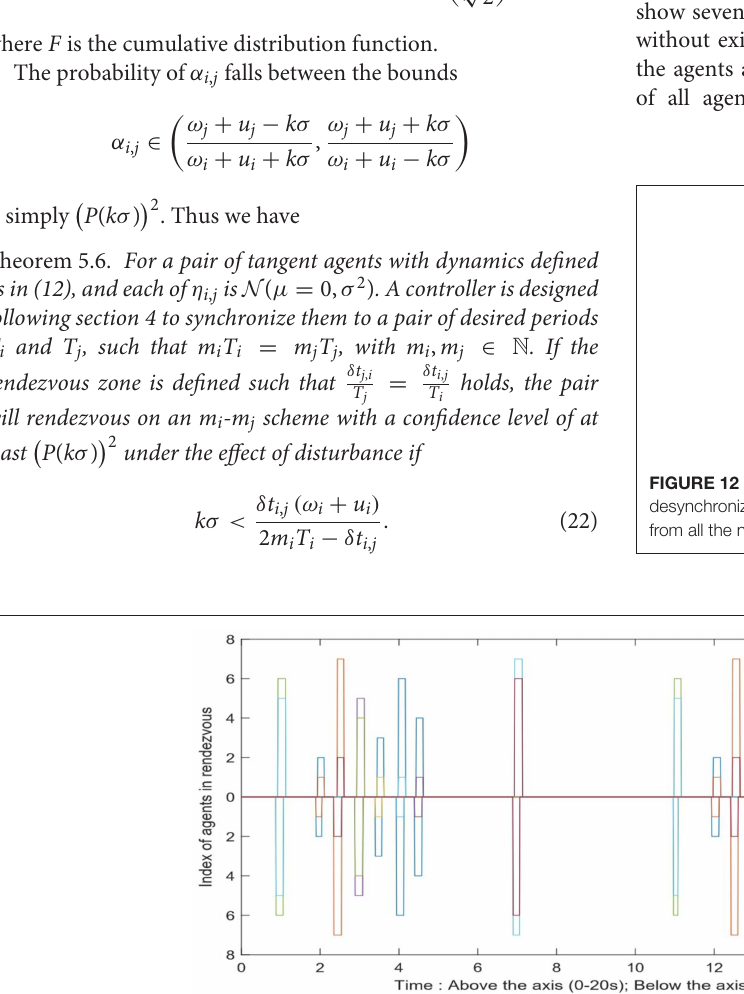
FIGURE 11 | The comparison between the rendezvous events in the beginning and near the end of the simulation. Every bar has two readings, indicating that the two agents are in rendezvous at this time. The width of each bar is the rendezvous duration.